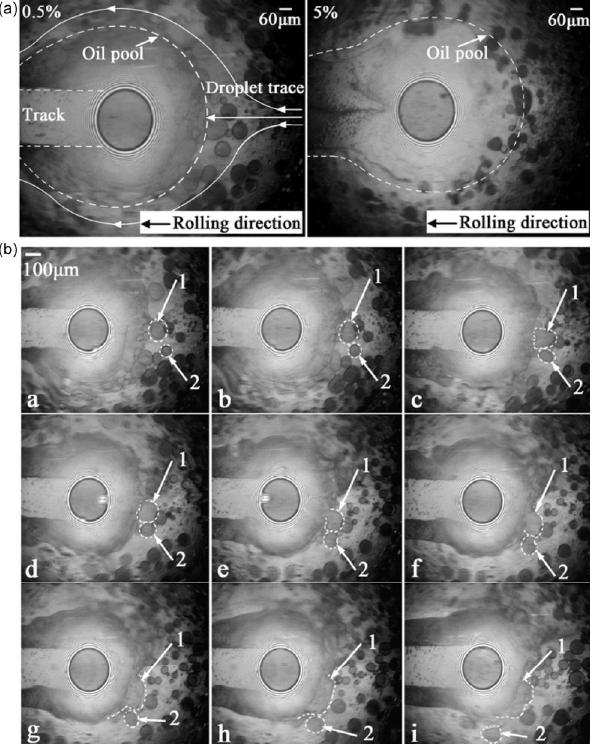
Fig. 25 Observation on the aqueous emulsion under a rolling speed of 0.005 m/s, achieved by Ma et al. (a) Trajectories of oil droplets; (b) two kind to typical droplets [122]. Copyright 2012, AIP Publishing